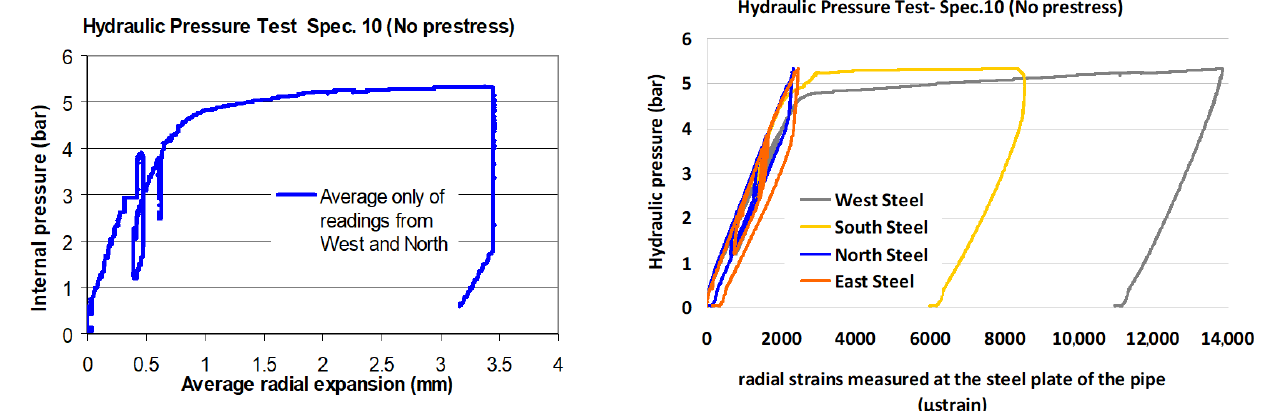
Figure 14. Measured response for Specimen 10 without prestressing: ( Left ) average radial expansion of the pipe radius; ( Right ) radial strains of the steel membrane (1 bar = 0.1 N/mm 2 ). Because the amplitude of the radial expansion for internal pressure above 2.8 bar recorded at two locations (East and South) for this specimen (Spec. 10) was found to contain erroneous readings, the plotted average radial expansion was based on readings taken at the other two locations (West and North).